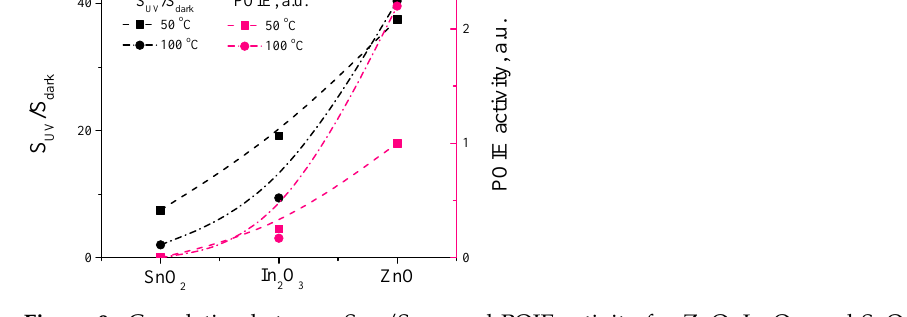
Figure 9. Correlation between S UV /S dark and POIE activity for ZnO, In 2 O 3 , and SnO 2 at 50 ◦ C (squares) and 100 ◦ C